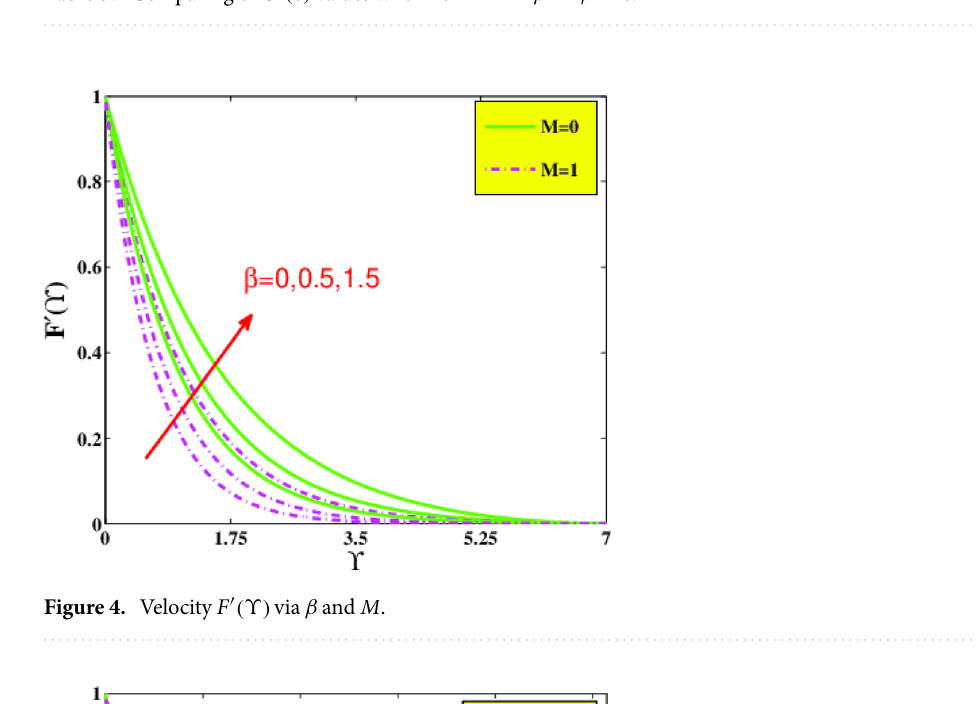
Table 3. Comparing of � ′ ( 0 ) values when Ec